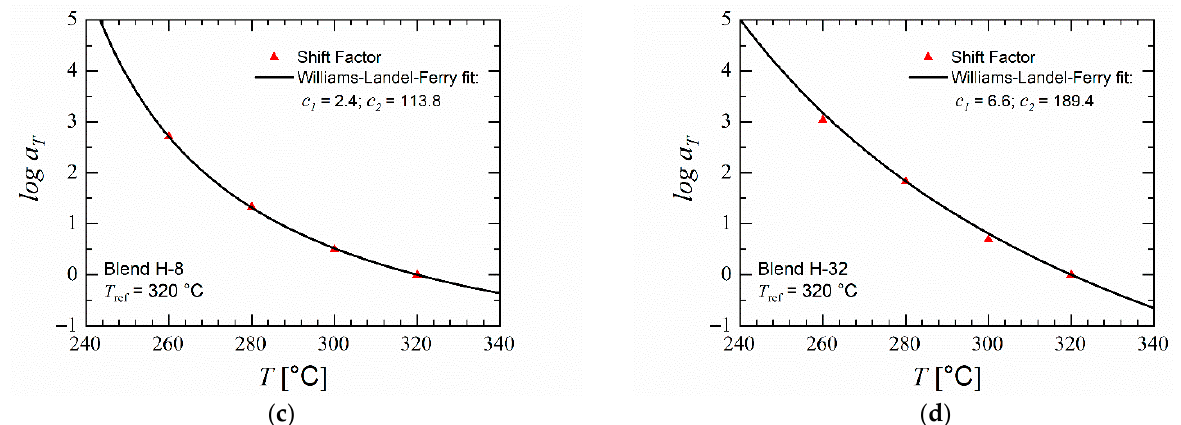
Figure 5. Rheological analysis of selected materials: ( a , b ) Master curve of blends H-8 and H-32; ( c , d ) Shift factor and WLF fit of blends H-8 and H-32.